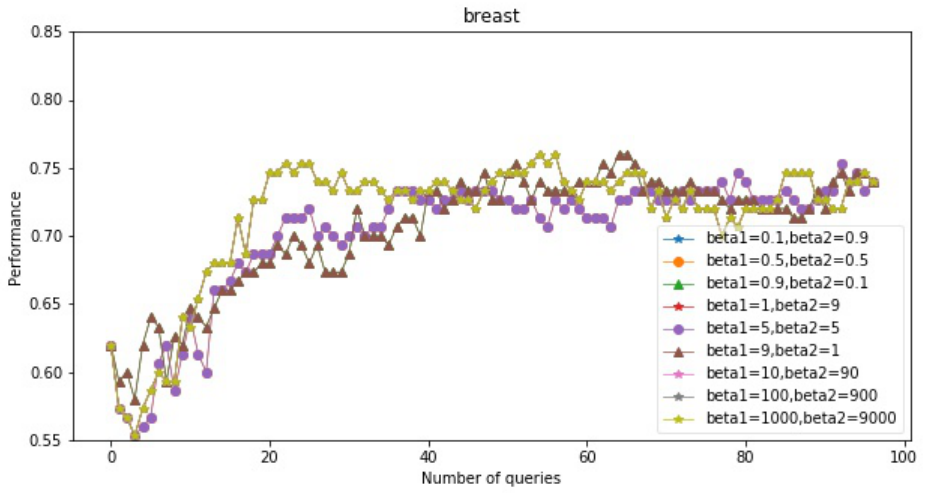
Figure 6. Performance comparison about different parameters on Breast